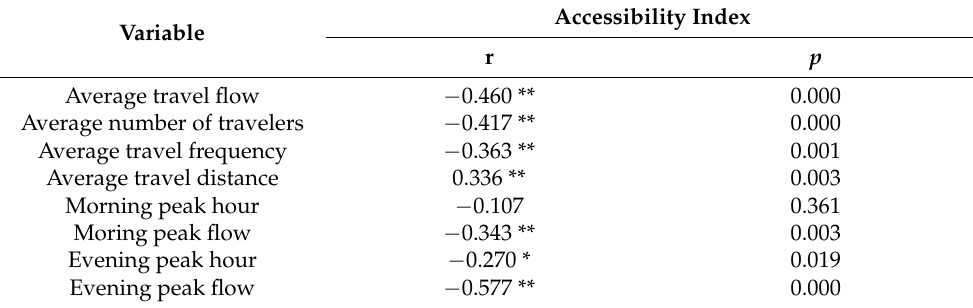
Table 6. Correlation analysis results of resident travel characteristics and accessibility index in 2015.